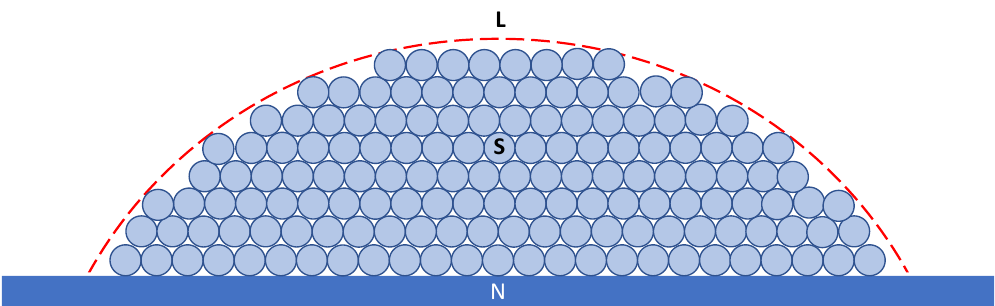
Figure 9. Schematic illustration of curvature formation (the red dashed line) as a consequence of structural templating during the formation of a spherical solid cap (S) on a substrate (N) from the liquid (L). Structural templating requires a solid atom to be supported only by solid atoms in the next solid layer underneath it. This means that during both nucleation and growth, a new solid layer always contains a smaller numbers of atoms than its previous layer.